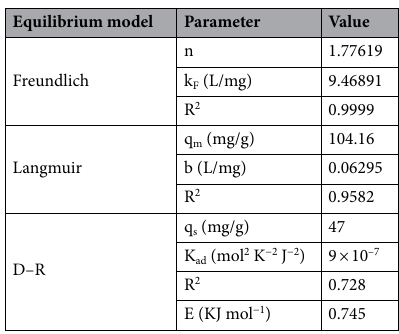
Table 2. The parameters of Freundlich, Langmuir and D–R isotherms models for adsorptive removal of CR